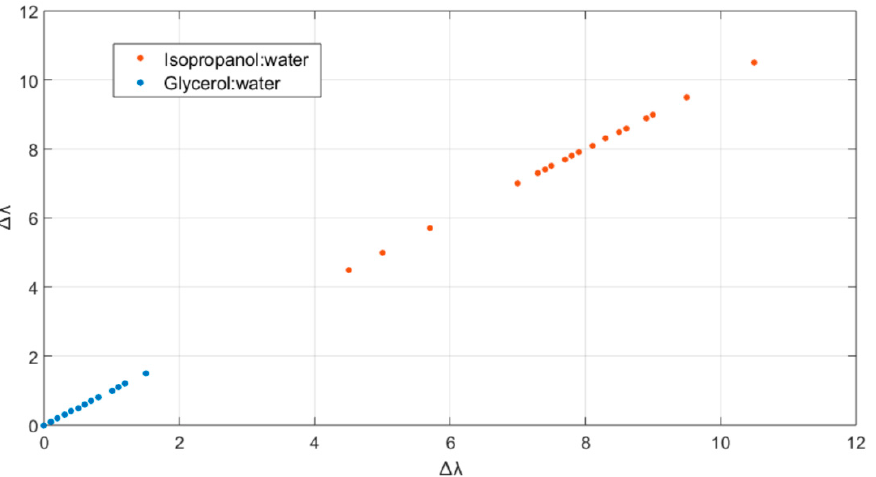
Figure 7. Scatter plot of the implemented dataset: two solutions with the same RI, but with (red, isopropanol:water) and without (blue, glycerol:water) the alcoholic component.